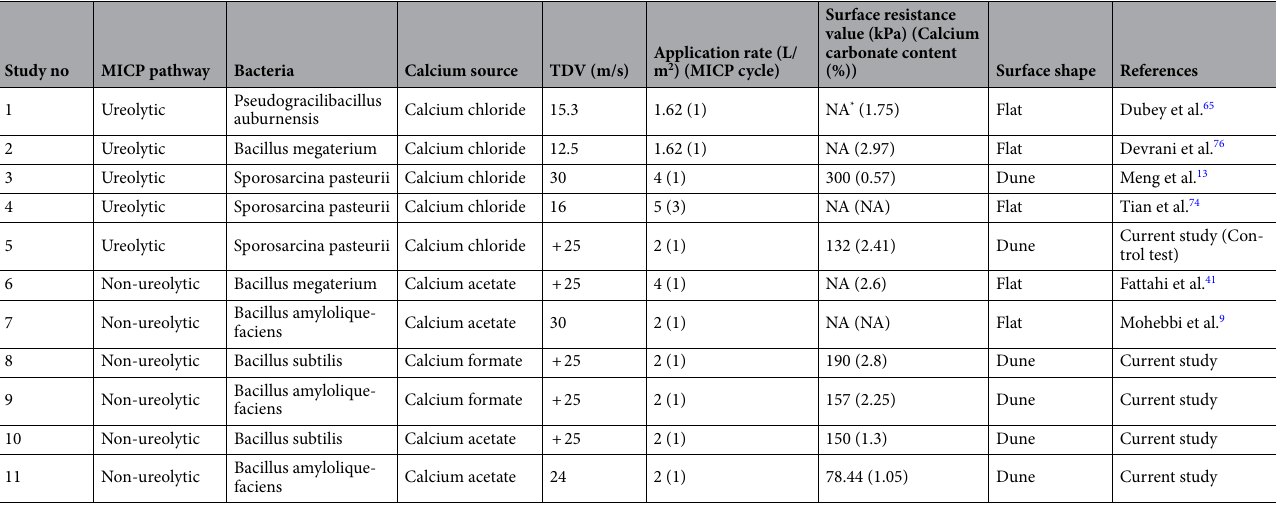
Table 2. Ureolytic versus non-ureolytic MICP for wind erosion mitigation. * NA: the values were not